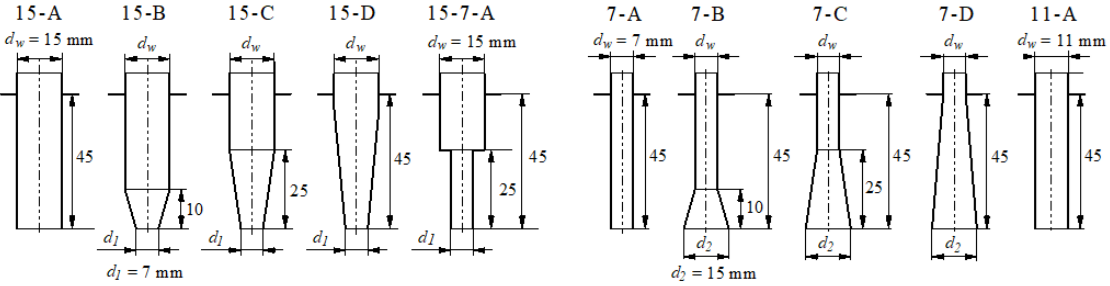
Figure 13. Geometry and dimensions of the cyclone outlet tube. Drawing made by author based on data from work [80].